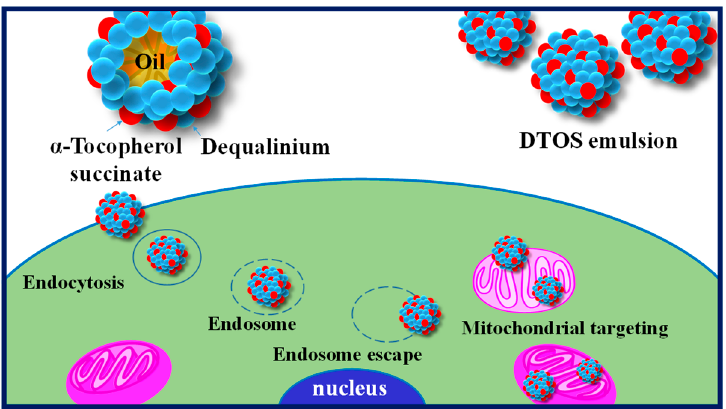
Figure 1. Illustration of the cellular uptake and mitochondria-targeting of the DTOS emulsion .